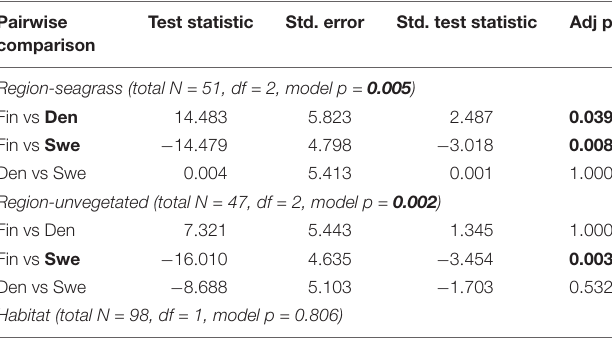
TABLE 2 | Summary of non-parametric Kruskal–Wallis tests of methane emissions among regions within (seagrass meadows and unvegetated areas) and between habitats.